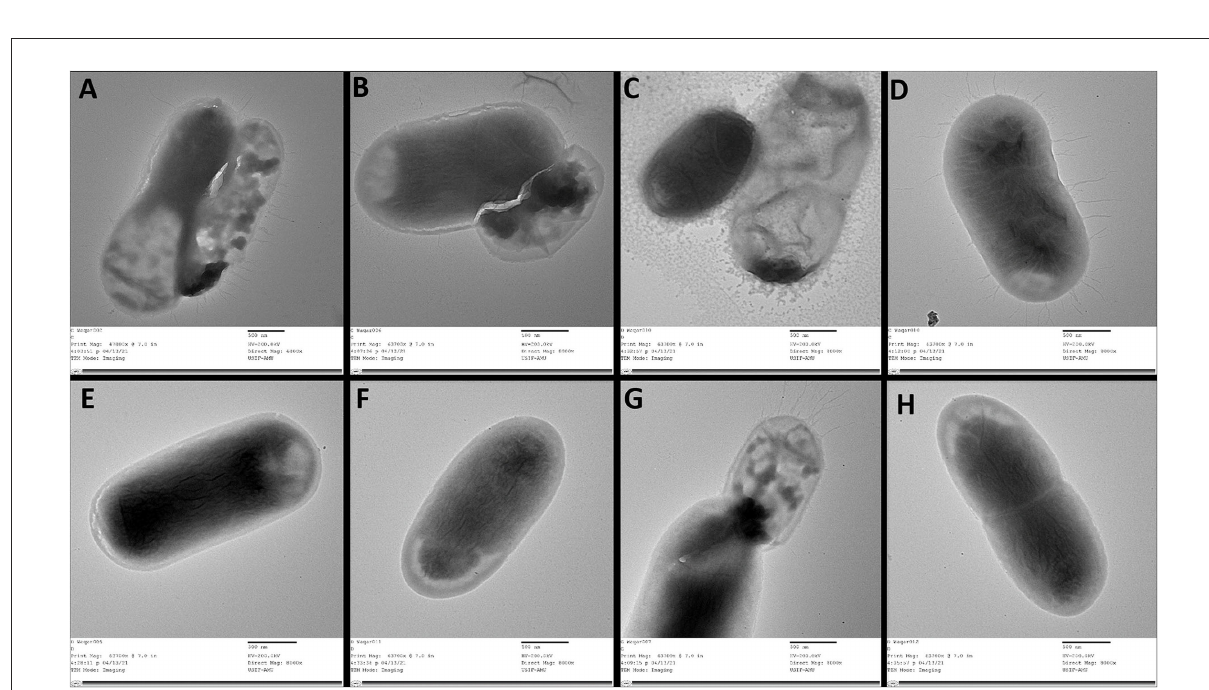
FIGURE6 TEM images of csgD- KD cells of EcN and K12. (A–D) shows control of TEA, TKA, TEB, and TKB, respectively, while (E–H) represents the csgD -KD cells of TEA, TKA, TEB, and TKB. The control cells show a large number of fimbriae, curli amyloid fibers, and other cell surface extremities, while the csgD -KD cells show no fimbriae on their cell surface. All images were taken on a 500-nm scale.